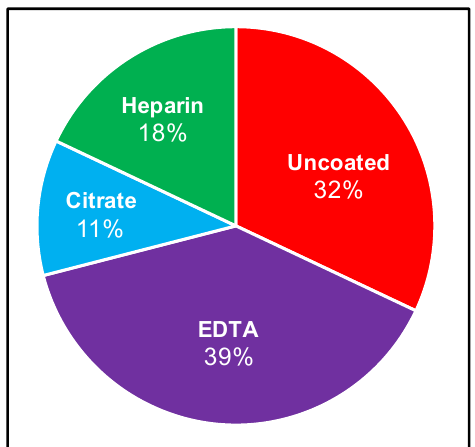
Figure 1. Reported use of anticoagulants to recover Borrelia from human blood. Relevant literature was curated (as described in Materials and Methods) to compare which vacutainers are commonly used when conducting Borrelia clinical culture from patient samples. Percentage calculated as number of times the vacutainer was used relative to the total experiments conducted using vacutainers in a set of applicable studies.